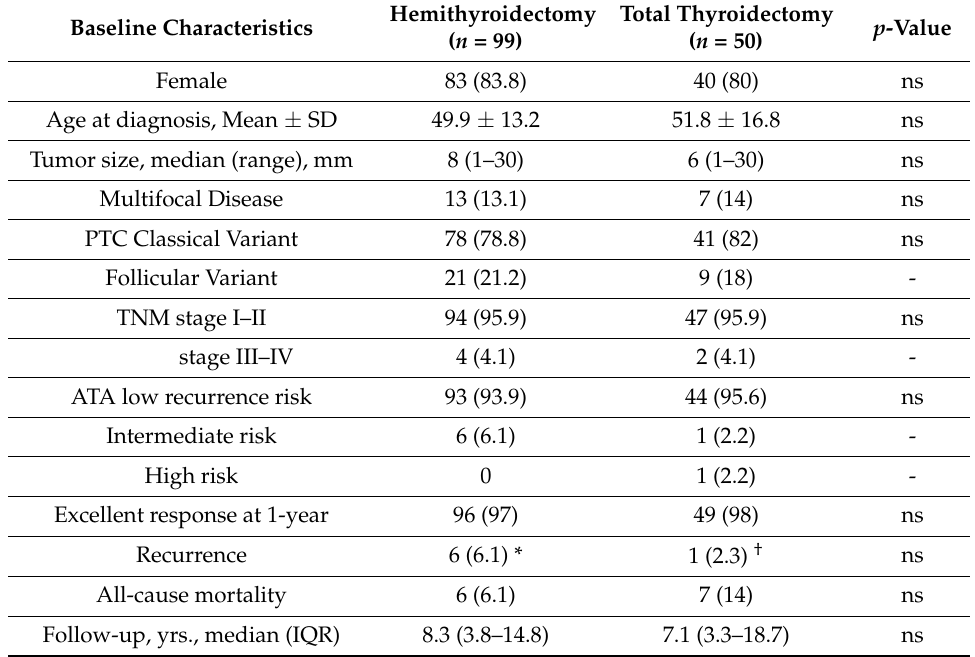
Table 6. Baseline characteristics and disease outcome of unilateral papillary thyroid cancer (PTC) patients treated with hemithyroidectomy and total thyroidectomy with no RAI as initial